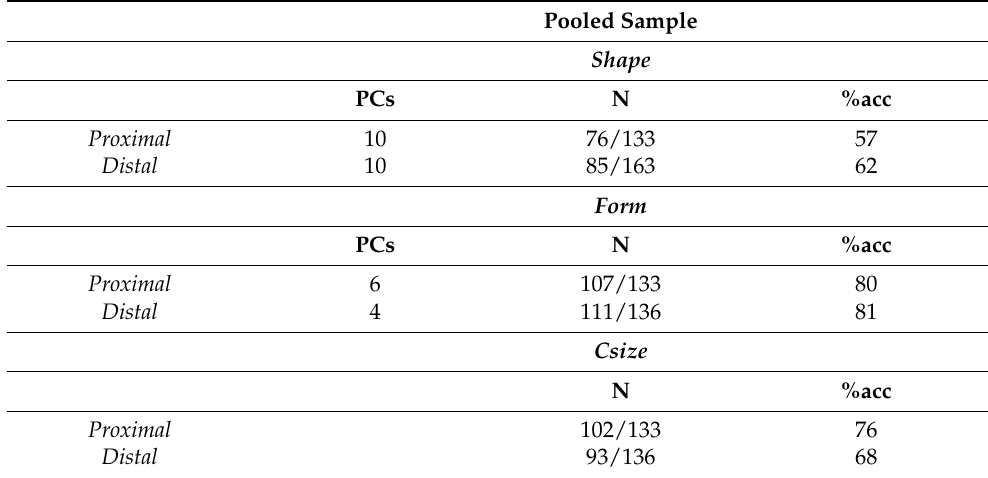
Table 4. Sex determination accuracy percentages obtained by cross-validation LDA on the pooled sample (Emilia-Romagna, Sardinia, and South Africa) for shape and form PC scores (PCs) and centroid size (CS) of proximal and distal epiphyses.